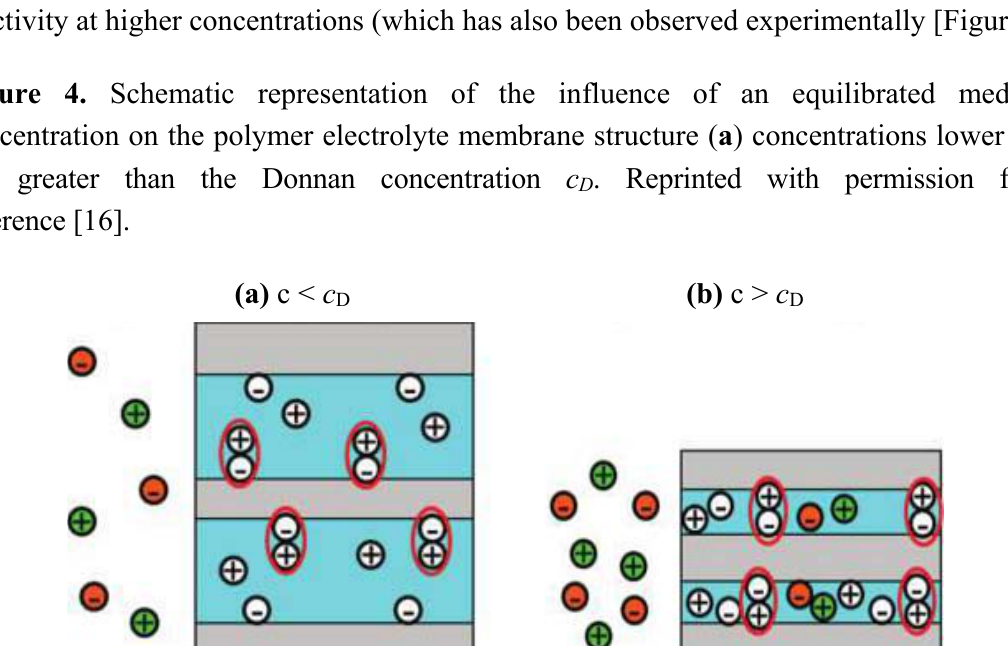
. Reprinted with permission from D